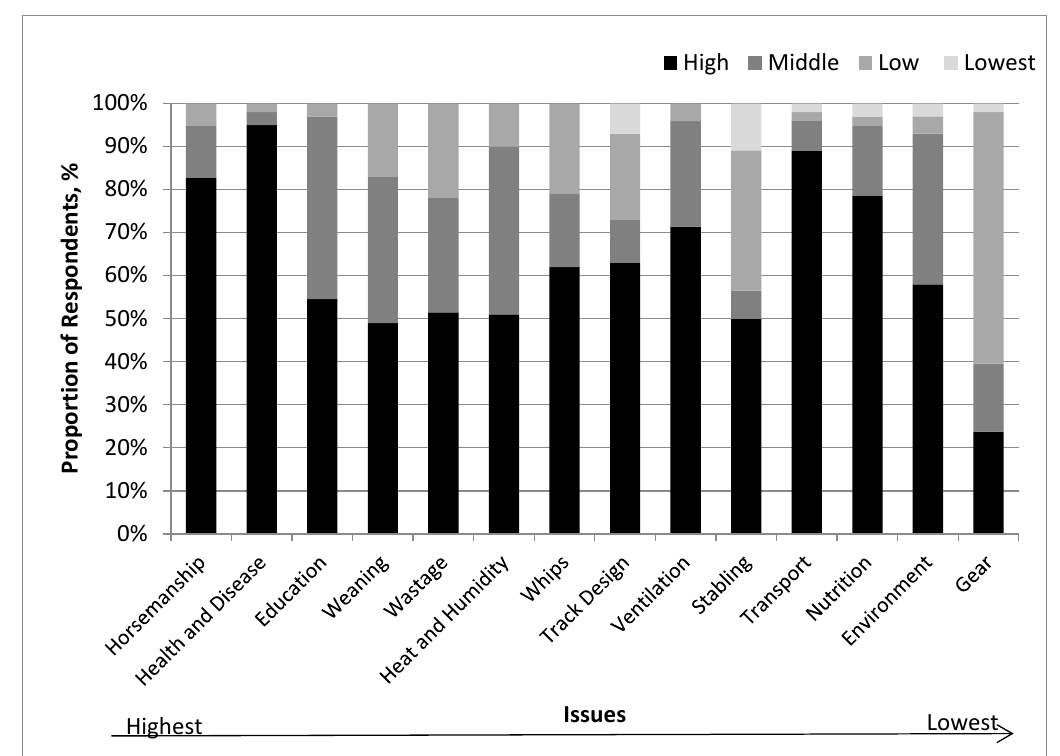
Figure 6. The percentage of TBR trainers selecting each issue level (lowest, low, middle, high) in Study 2, with issues ordered from highest (lefthand side) to lowest (righthand side) importance. In the PCR of TBRWI issues, the five components with eigenvalues of more than 1.0 explained 63% of the variance. The loading plot for the first two, which explained 20 and 15% of the variance, respectively, is illustrated in Figure 7. These had eigenvalues of 2.82 and 2.08, respectively. This showed that the use of gear was antagonistically related to animal ‐ related issues in the first principal component, which, in turn, were antagonisti ‐ cally related to facility ‐ related issues, including ventilation, stabling, track design, envi ‐ ronment, heat and humidity, etc.